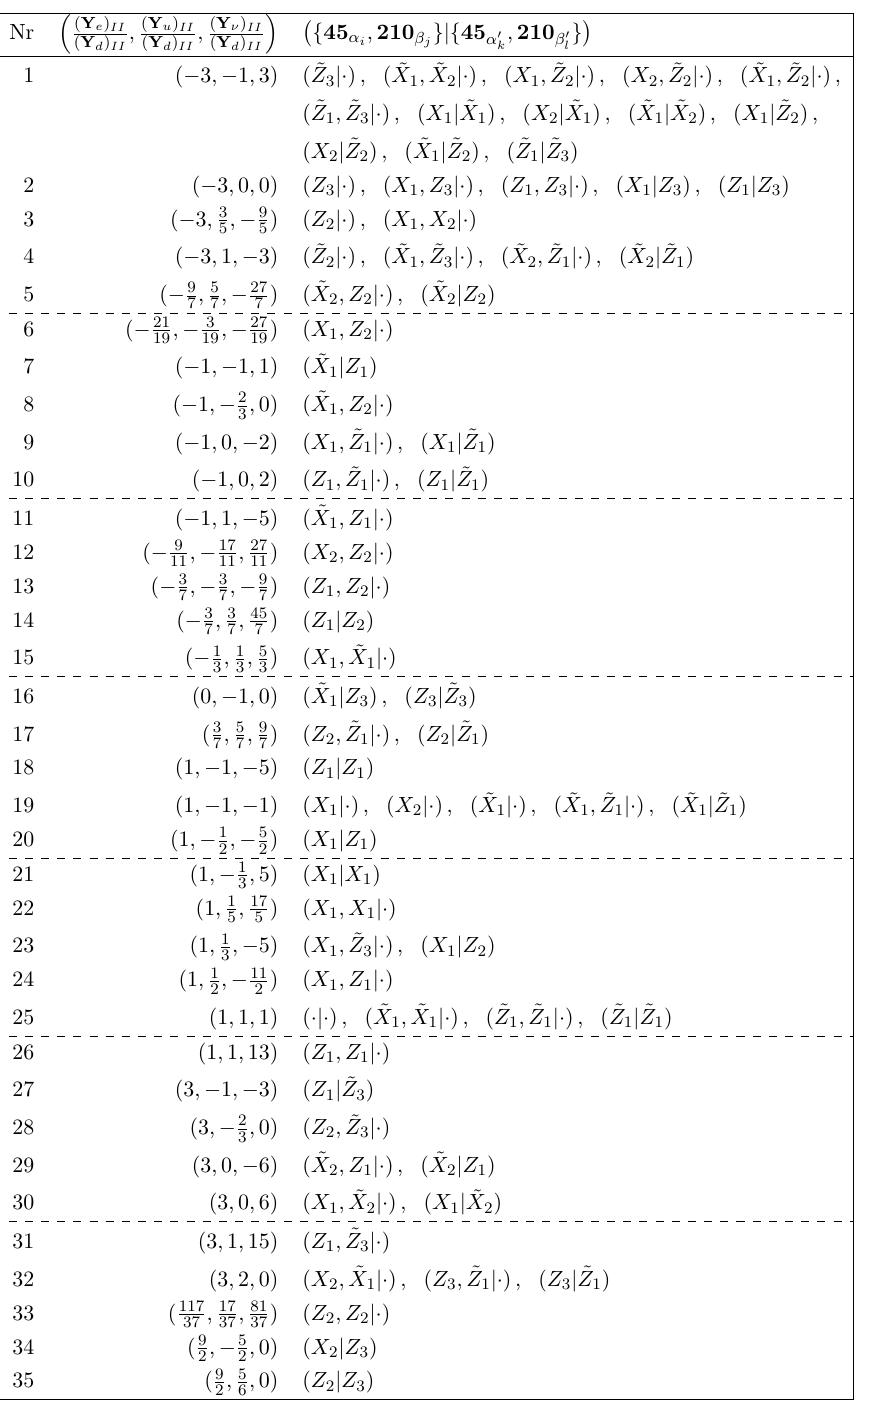
Table 5 . A list of Yukawa ratios generated from eq. (2.18) with H = 10 and the predictive Higgs sector case #1 from table 4. This is a complete list for operators up to dimension (cid:12)ve in W (i.e. n + n 0 + m + m 0 (cid:20) 2), using the well de(cid:12)ned SU(5) and Pati-Salam alignments from eq. (2.9) and (2.10) for the singlet VEVs of the 45 and 210 , and which provide j ( Y e ) II = ( Y d ) II j (cid:20) 8. The last column lists the alignements of the SM singlet VEVs which provide the corresponding tuple of Yukawa ratios, where the vertical bar separates the (cid:12)elds f 45 (cid:11) f 45 ; 210 g on the right-hand side of the 10 . A dot means no (cid:12)eld on that side of the Higgs. (cid:11) 0 (cid:12) 0 k l